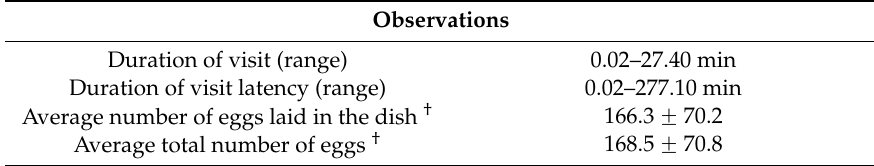
Table 2. Duration of single visits, visit latency, and number of eggs laid by Plodia interpunctella during two consecutive 10-h periods that each included an 8-h scotophase in Study 3.